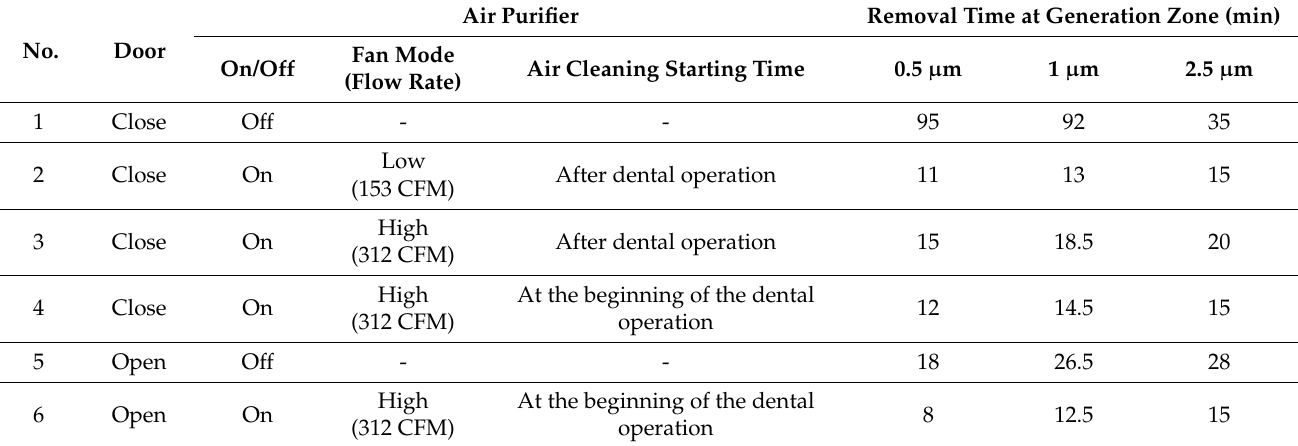
Figure 4. Temporal change of particle concentrations of 0.5- µ m particle in the generated zone in ( a ) closed-door and ( b ) open-door cases. Table 4. Removal times of the cases at the generation